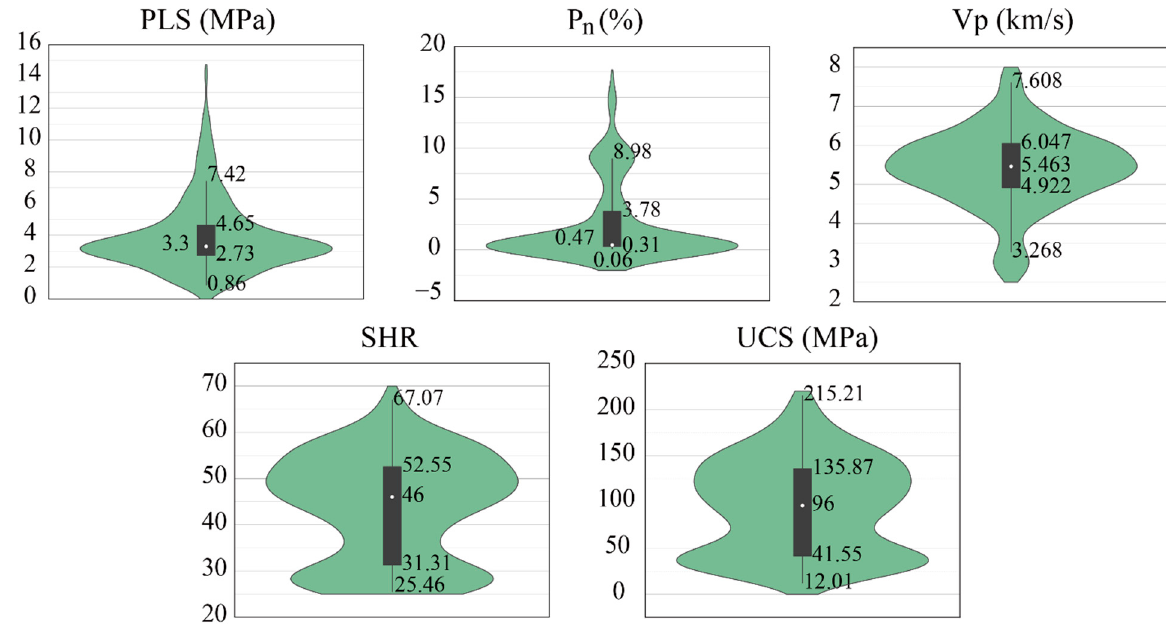
Figure 3. Violin plots of input and output variables.